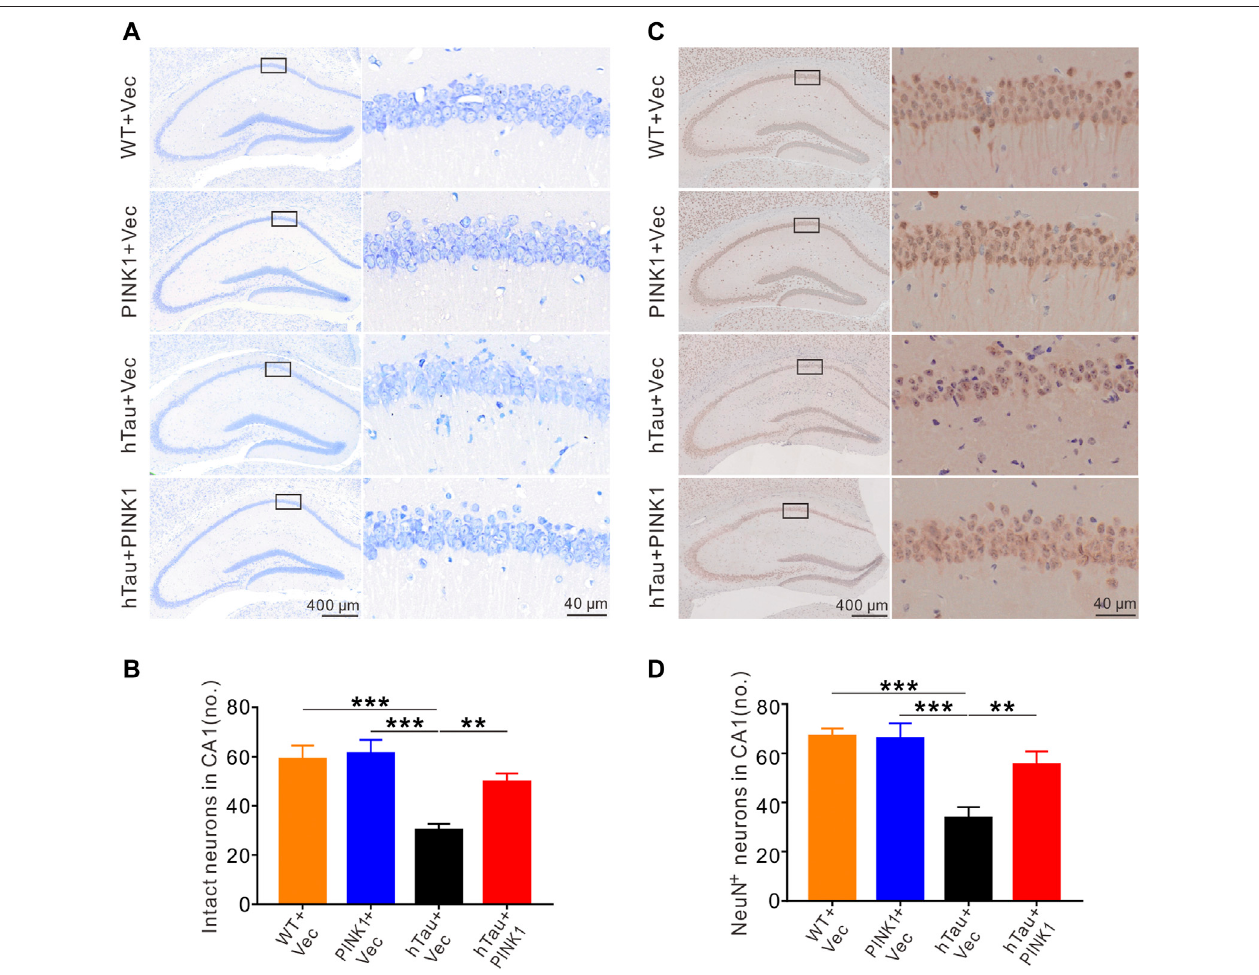
FIGURE 2 | PINK1 alleviates hTau-induced neuronal loss in the hippocampal CA1 region of mice. ( A) PINK1 ameliorated hippocampal CA1 neuronal loss in hTau miceexhibitedbyrepresentativeimages ofNisslstaining. (B) Quantitativeanalysisofnumbersofintactneuronsinareaframedwithinblackbordered rectangle.Neurons with visible nuclei, distinctive nucleolus, and cytoplasmic Nissl staining were regarded as intact neurons and counted. One-way ANOVA followed by Tukey multiple- comparisons tests. ** p < 0.01, *** p < 0.001. (C) Representative images of NeuN immunohistochemical staining. (D) Quantitative analysis of numbers of